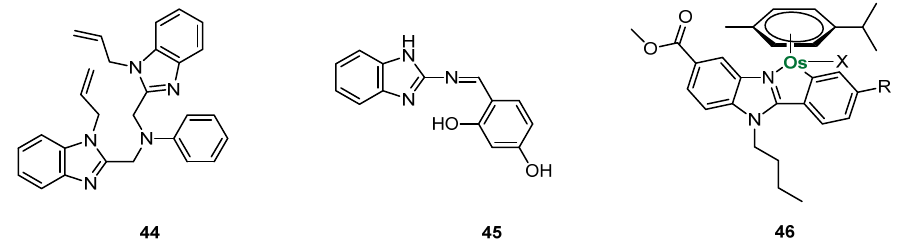
Figure 22. Transition metal complexes with benzimidazole.